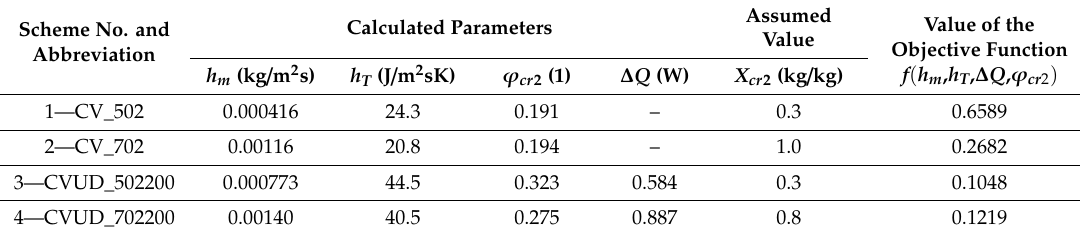
Table 2. Results of the model parameters determination for carrot samples.